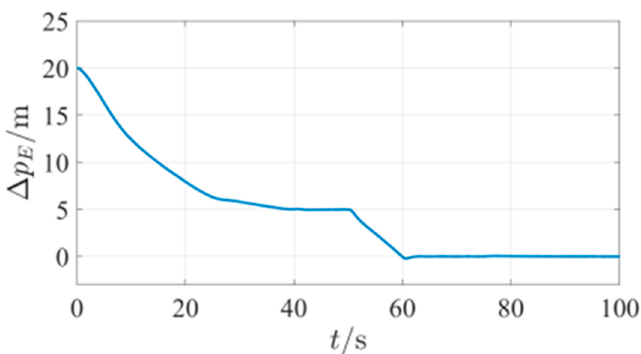
Figure 38. The relative displacement between east and west direction of the mobile platform during landing process.